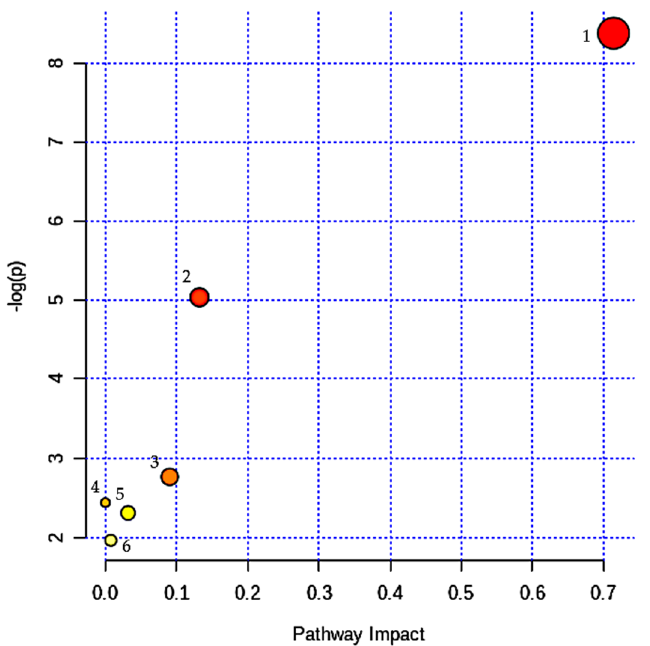
Figure 7. Summary of pathways analysis with MetaboAnalyst 4.0 (18 April 2020): (1) Taurine and hypotaurine metabolism, (2) Tryptophan metabolism, (3) Citrate cycle, (4) Alanine, aspartate, and glutamate metabolism, (5) Glyoxylate and dicarboxylate metabolism, (6) Primary bile acid biosynthesis.